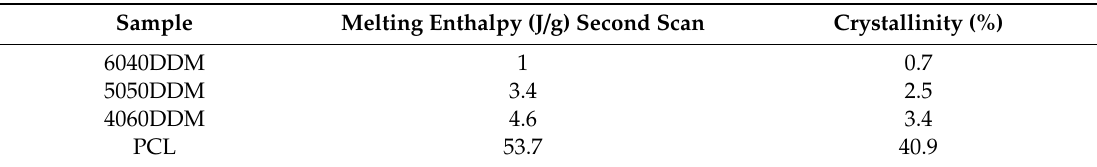
Table 1. Crystallinity of di ff erent composition DGEBA / PCL blends cured with DDM.